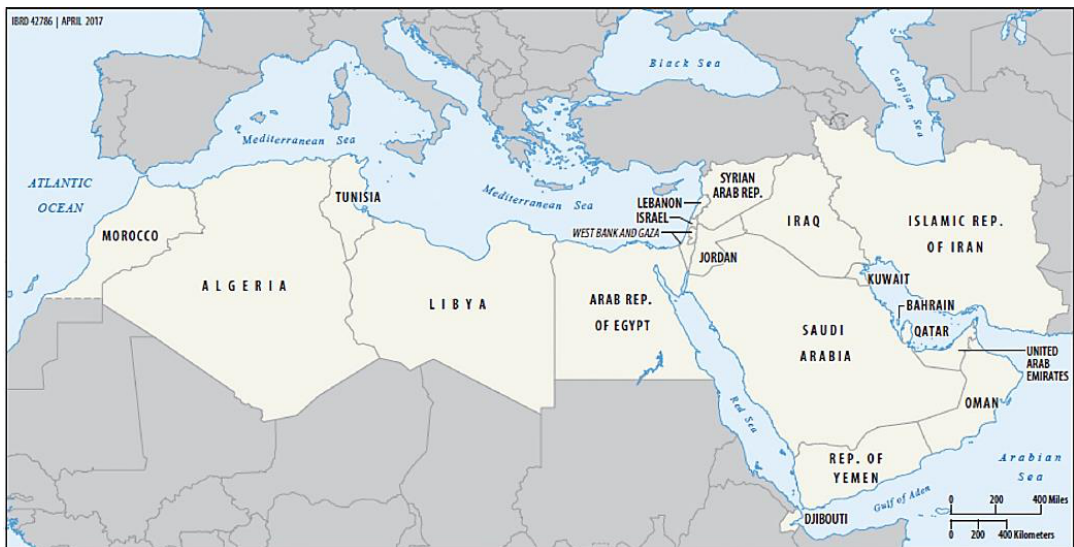
Figure 1. Map of the Middle East and North Africa (MENA) region; source: [12] .